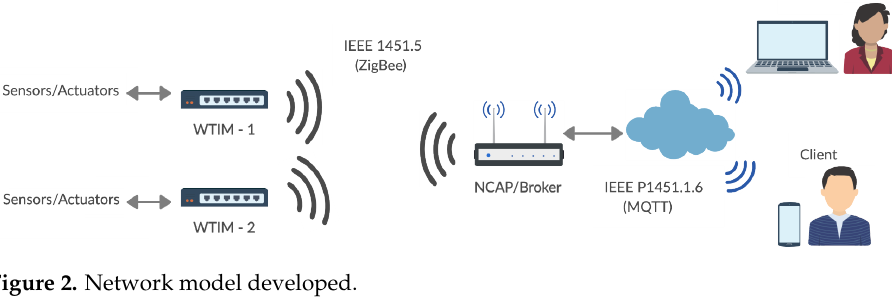
Figure 2. Network model